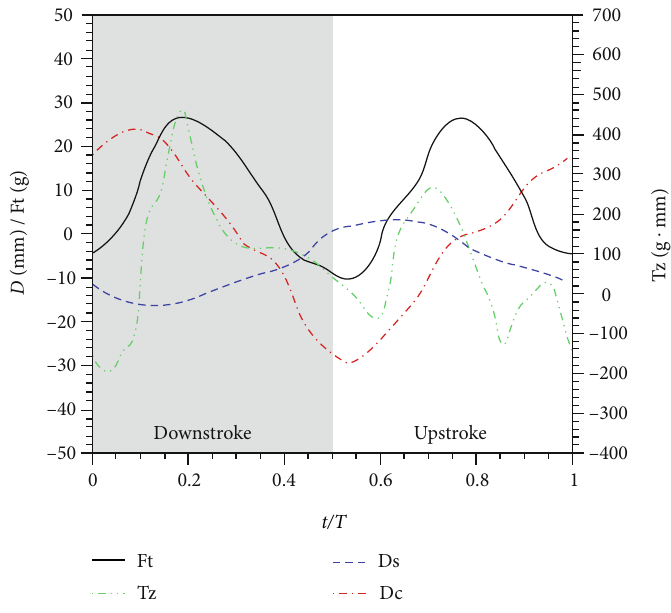
Figure 12: Relationship between deformation and aerodynamic characteristics in a fl apping